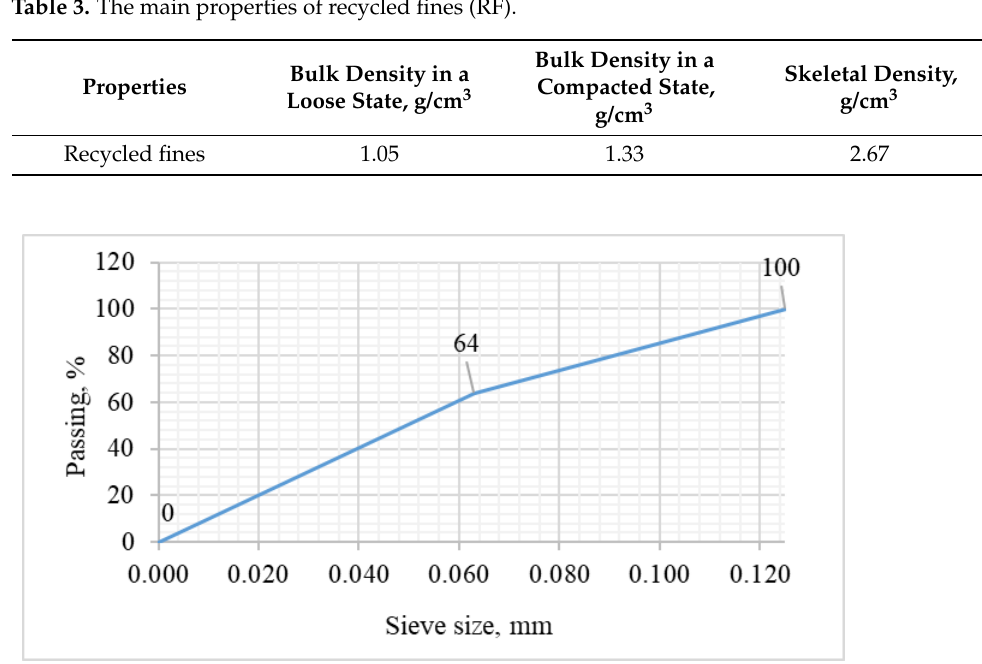
Figure 4. Sieve analysis curve for recycled fines; 0.125 mm size.